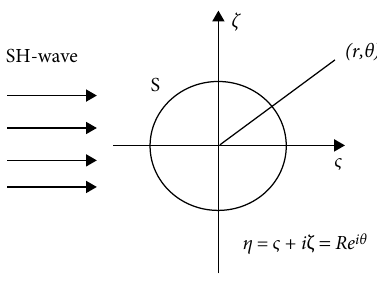
Figure 2: The conformal mapping of an arbitrary shaped nano-